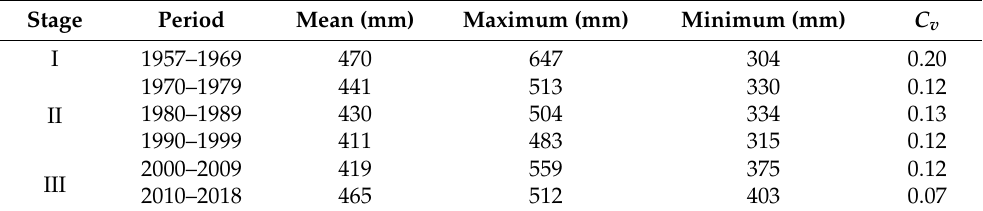
Table 2. The stage variation of annual precipitation across the Loess Plateau, China during 1957–2018. Stage